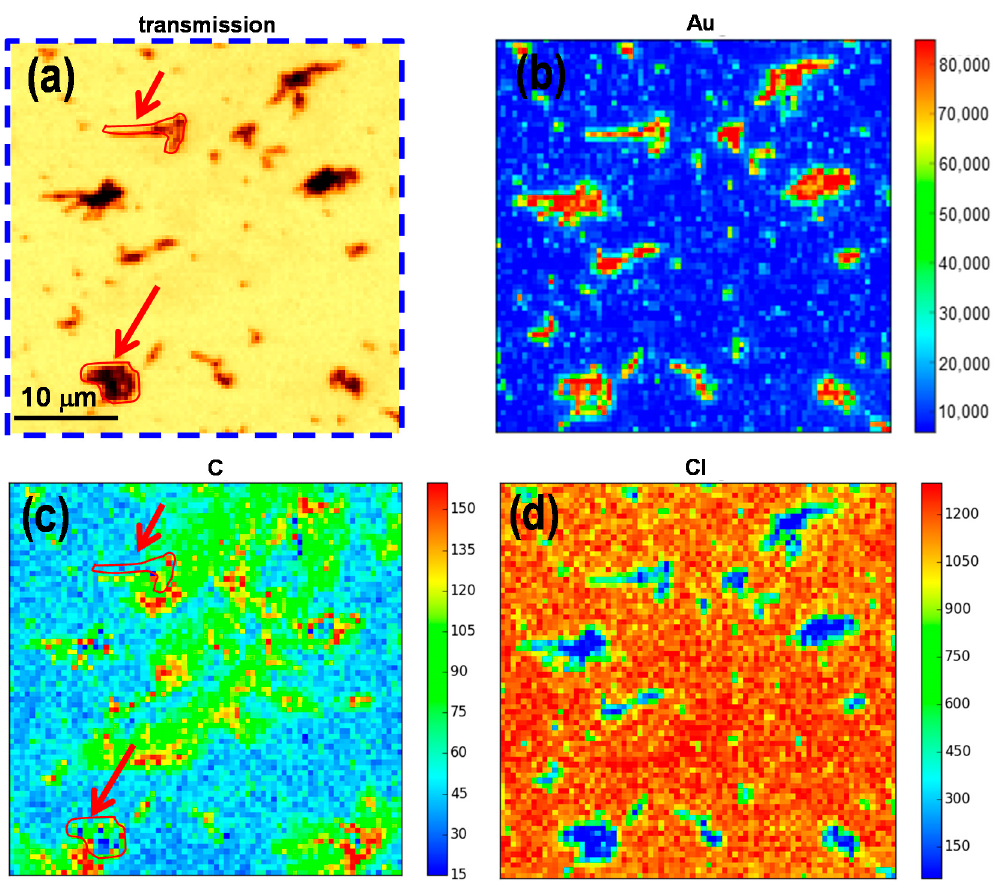
Figure 3. SXM image and XRF maps for P2-60-GNRs. ( a ) transmission image taken at 2.98 keV; ( b ) XRF map for Au M α ; ( c ) XRF map for C K α ; ( d ) XRF map for Cl K α . The two red contours, pointed out by arrows in carbon map ( c ) are drawn for clarification and showing the equivalent location of two chosen GNRs patches in image ( a ).